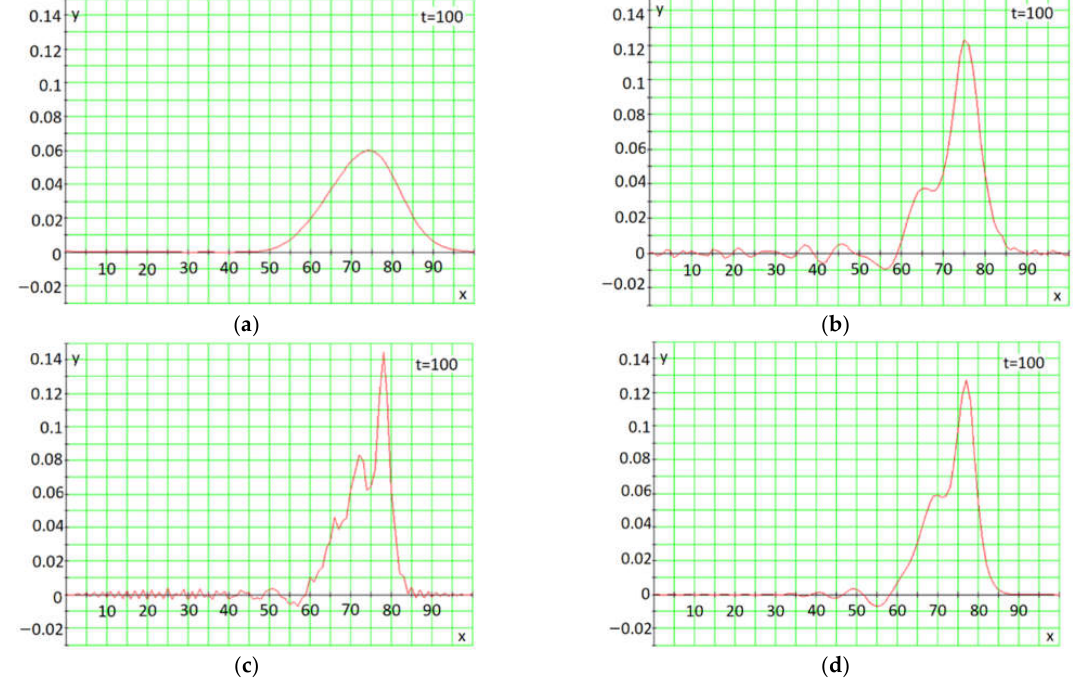
Figure 4. Numerical solution of the test nonlinear KdV problem based on the schemes: “left corner” ( a ), the “Standard Leapfrog” ( b ), the “Upwind Leapfrog” ( c ), the scheme (7) ( d ).